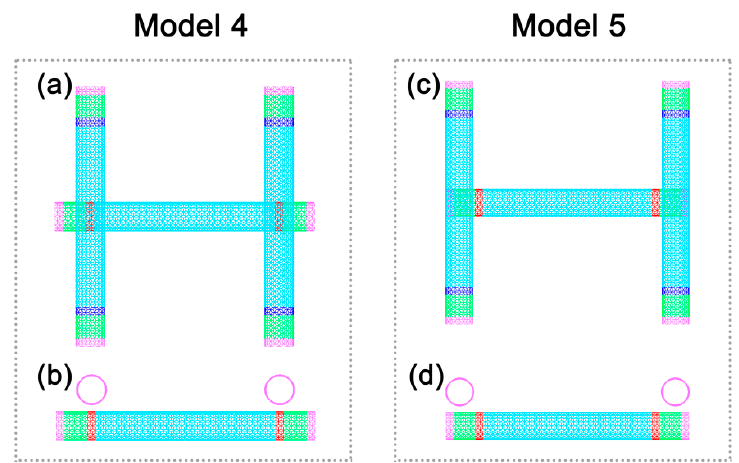
Figure 6. Calculation model 4 and model 5 for the contact conductance of the double thermal contacts: ( a , c ) aerial view; ( b , d ) front view.